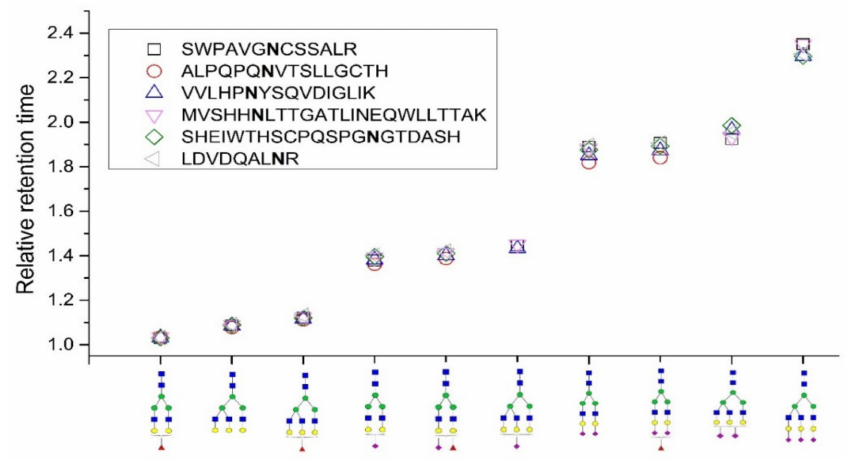
Figure 1. Relative retention times ( t r x glycoform / t r A2G2 glycoform ) of individual glycoforms attached to different